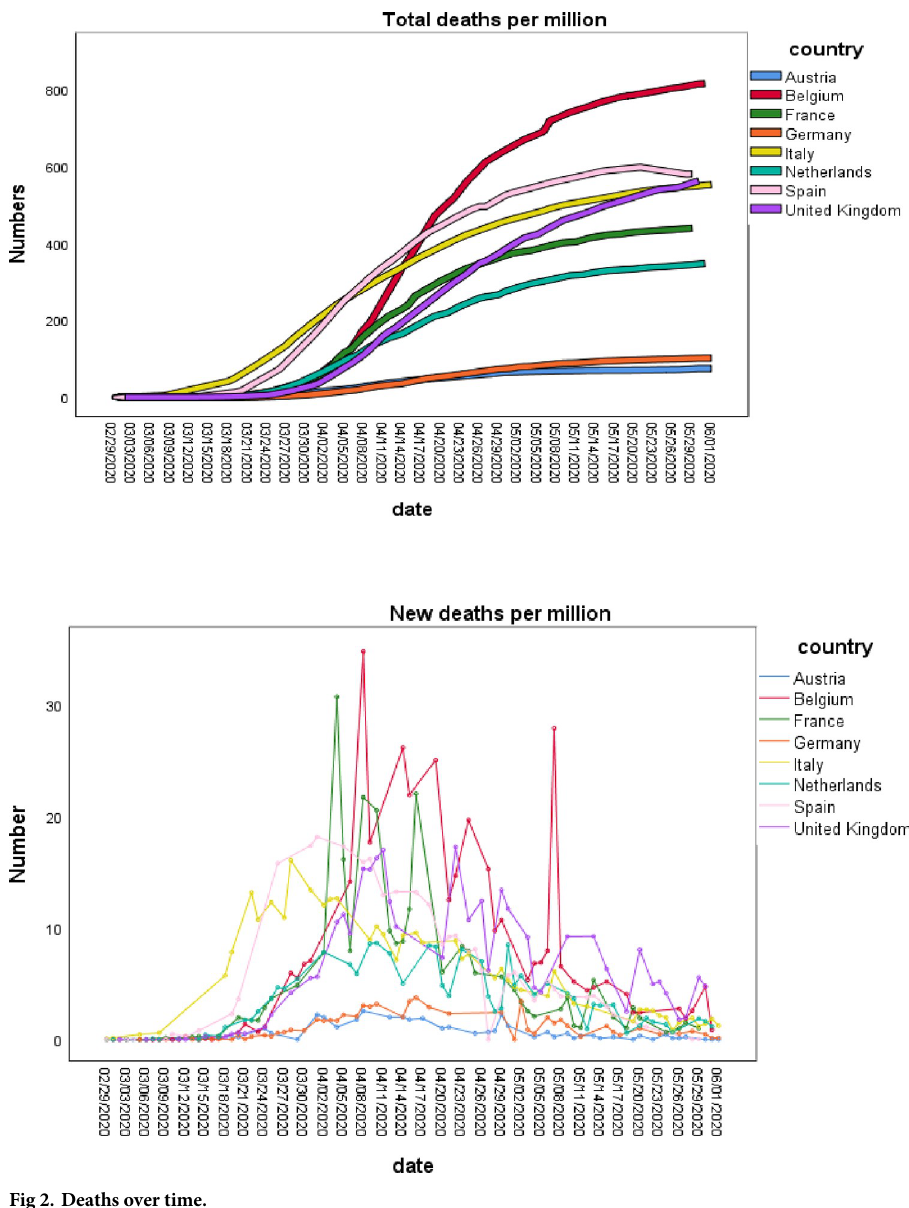
Fig 2. Deaths over